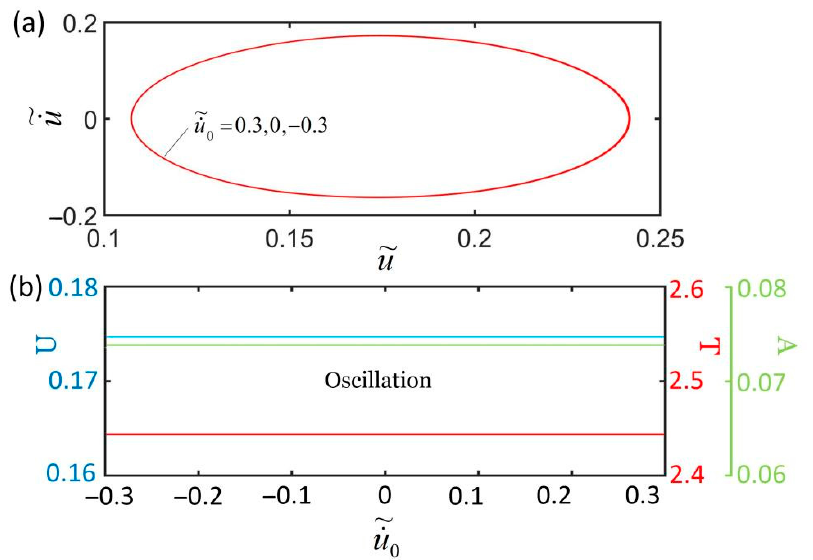
Figure 13. The effect of initial conditions on self-excited oscillation for (cid:101) I = 0.23, (cid:101) k = 5.8, (cid:101) c = 0.36,